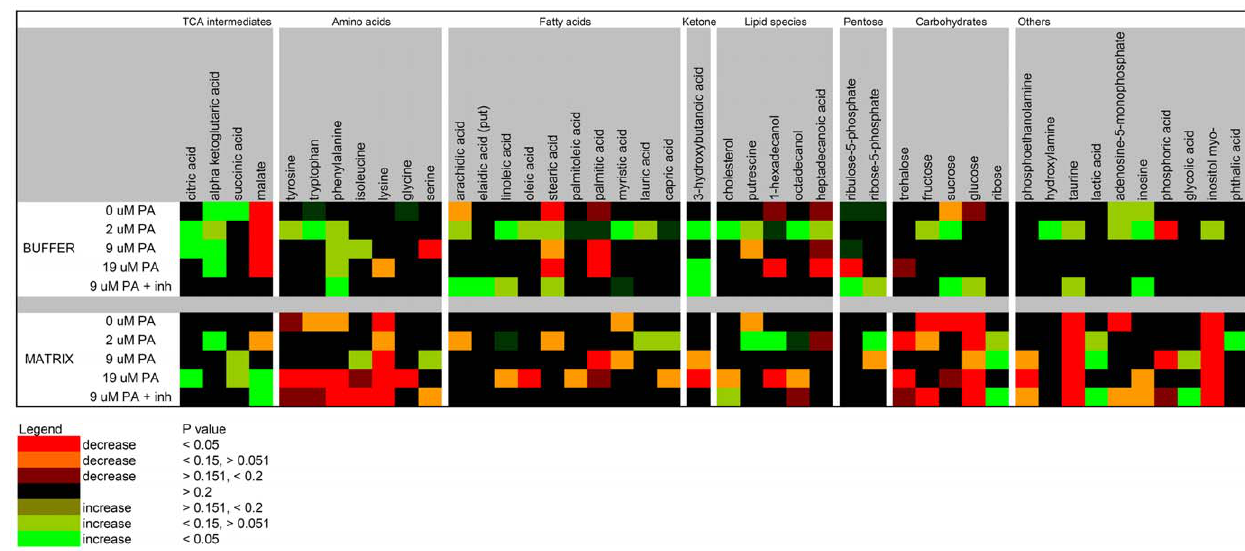
Figure 2. Heat map showing the identified metabolites from murine muscle mitochondrial preparations that changed in concentration over the course of the incubations. Metabolites are shown for which the concentration changed significantly during the 20-min incubation for one or more of the treatment conditions (0, 2, 9, and 19 m M palmitate, and 9 m M palmitate plus FAO inhibitors).